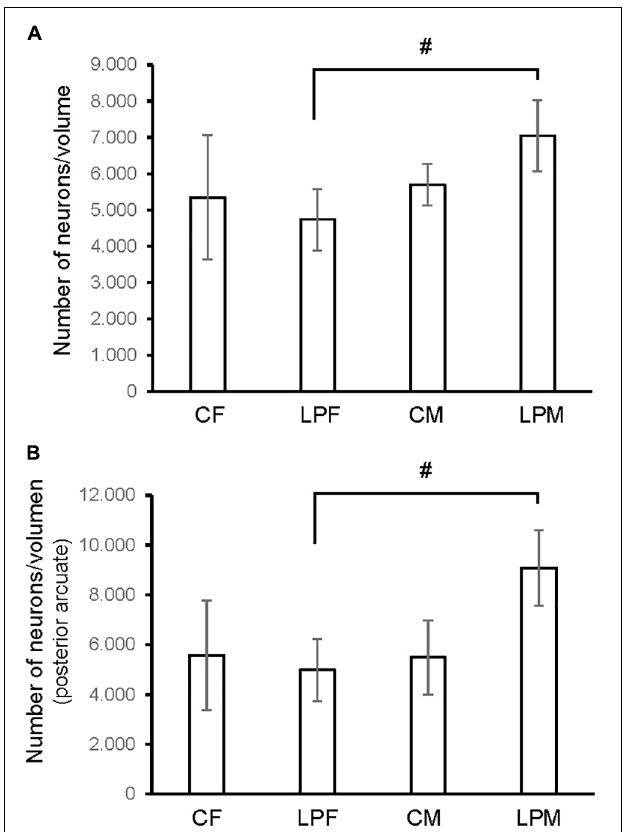
FIGURE 6 | Histogram shows the differences in neuron density (calculated as number of neurons/volume) in (A) ARC nucleus (B) posterior ARC subdivision. CM, control male; CF, control female; LPCM, low-protein and low caloric male; LPCF, low-protein and low caloric female. # Significant differences between groups ( p < 0.05 in all cases). All values are expressed as means ± SD.